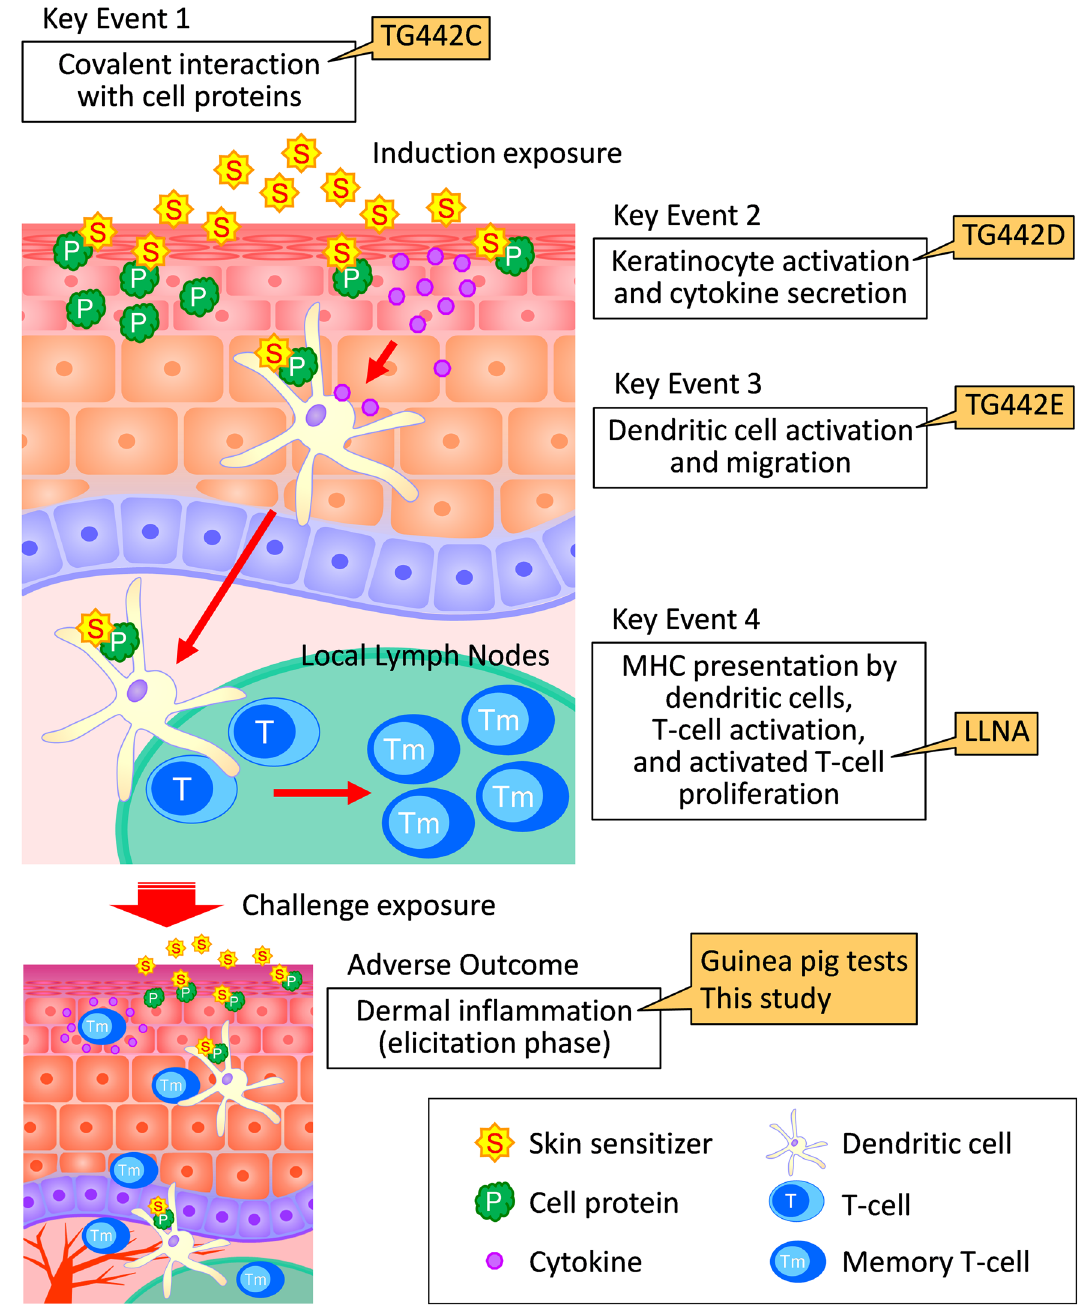
Figure 1. The OECD adverse outcome pathway (AOP) and test guidelines (TGs) for skin sensitization. LLNA local lymph node assay, MHC major histocompatibility